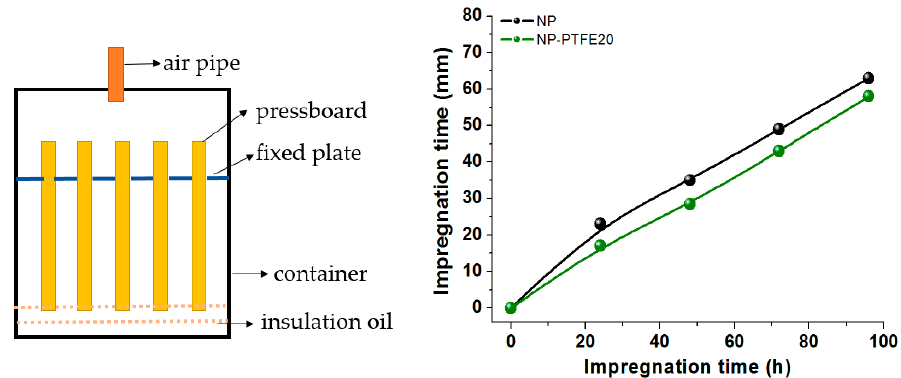
Figure 17. Oil impregnation experiment and result.